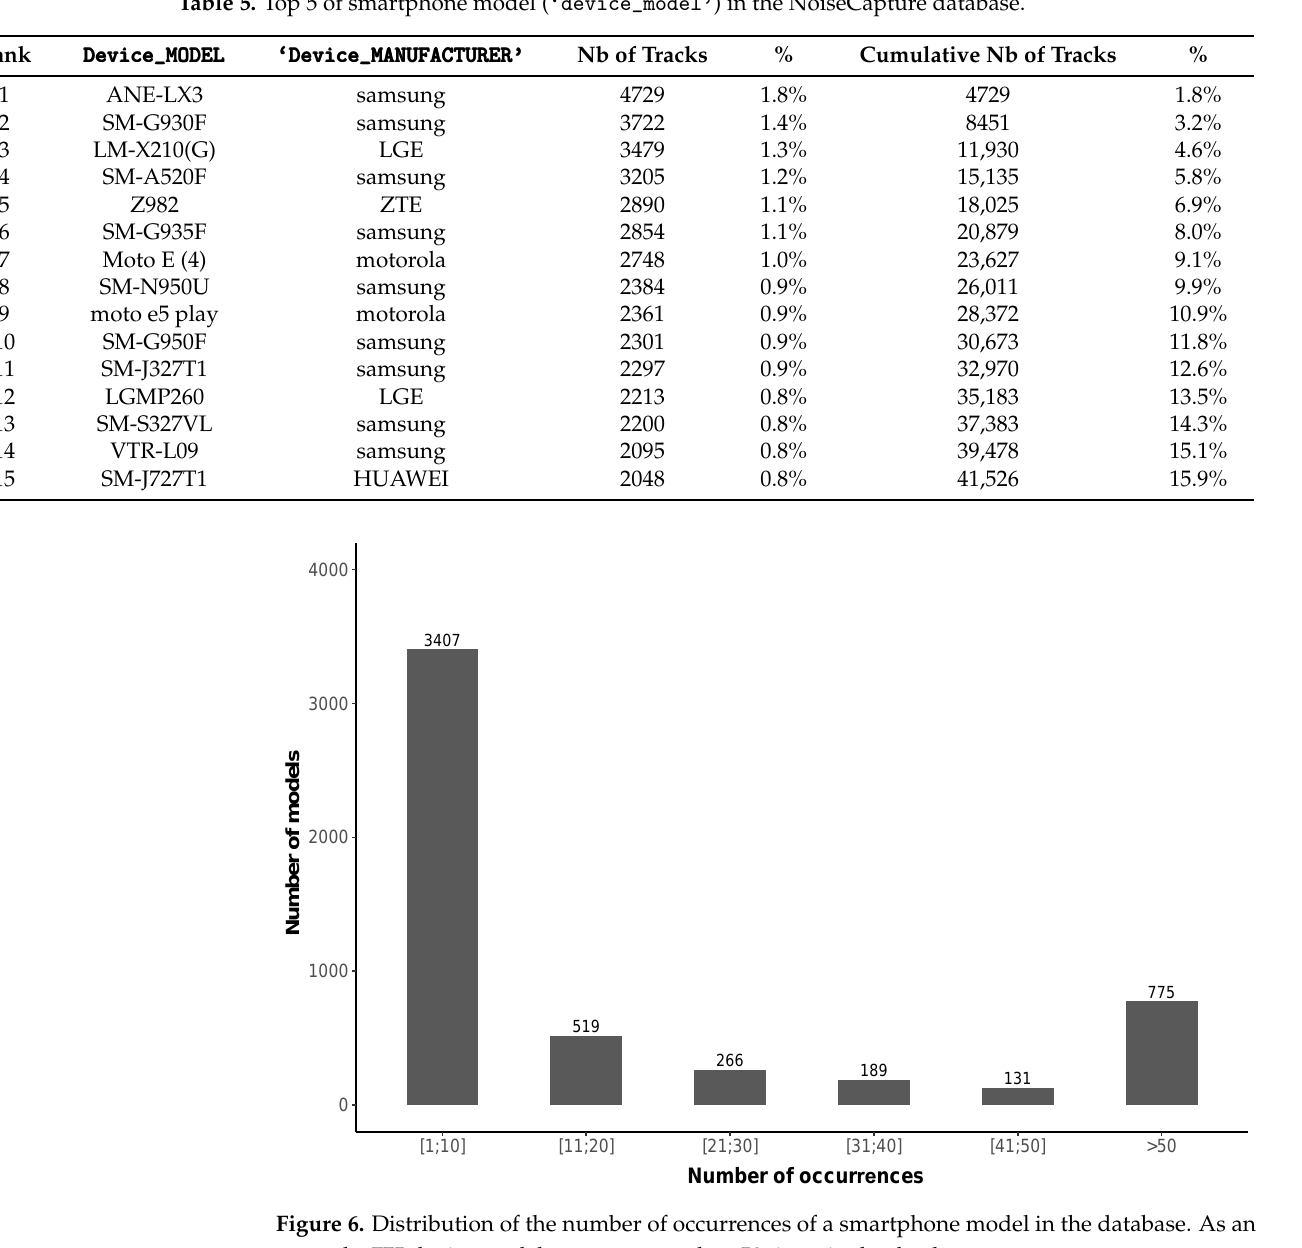
Table 5. Top 5 of smartphone model ( ‘device_model’ ) in the NoiseCapture database.